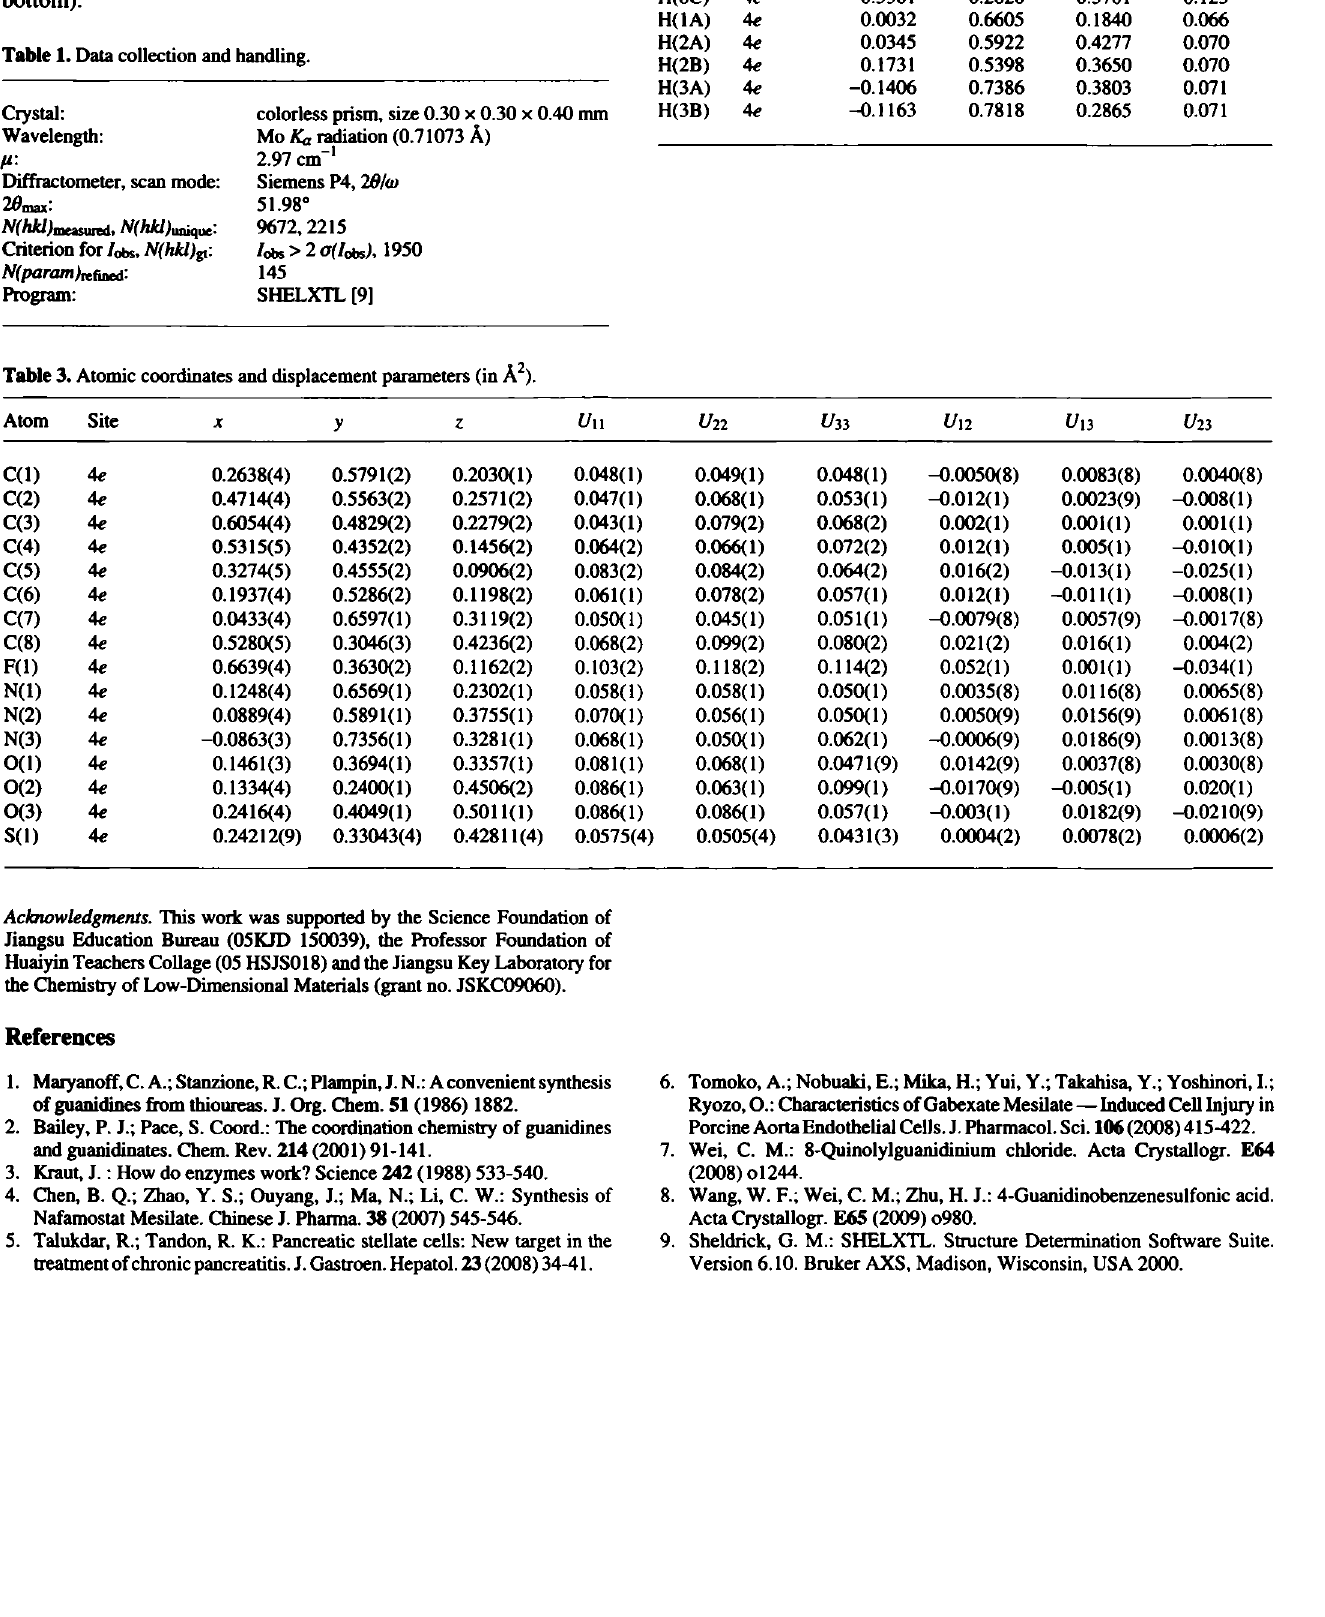
Table 1. Data collection and handling.